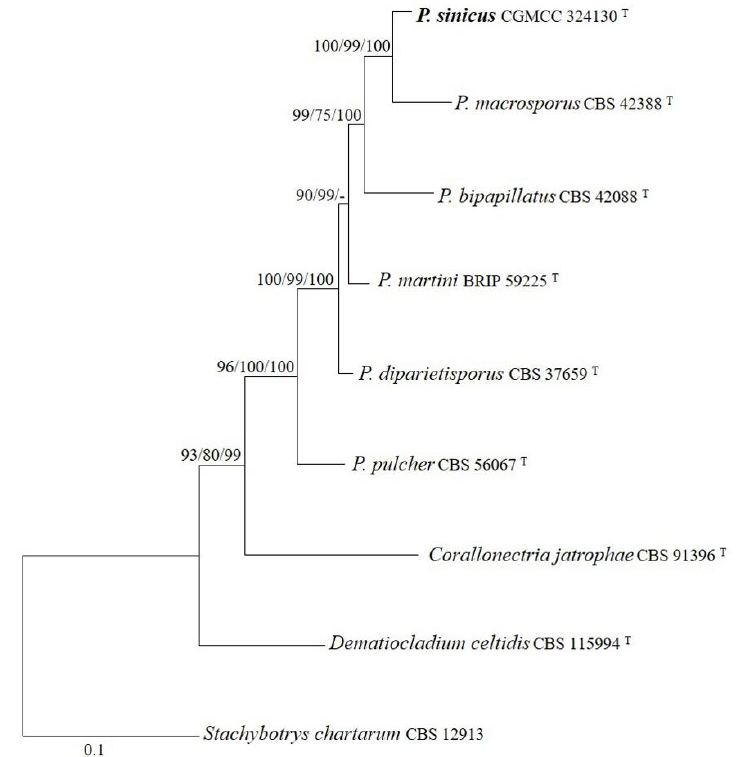
Figure 1. The maximum likelihood tree inferred from combined ITS, LSU, rpb2, and tef1 sequences of representative species of Penicillifer . MLBP ( left ) and MPBP ( middle ) values greater than 70% and BIPP ( right ) values greater than 90% are shown at the nodes.